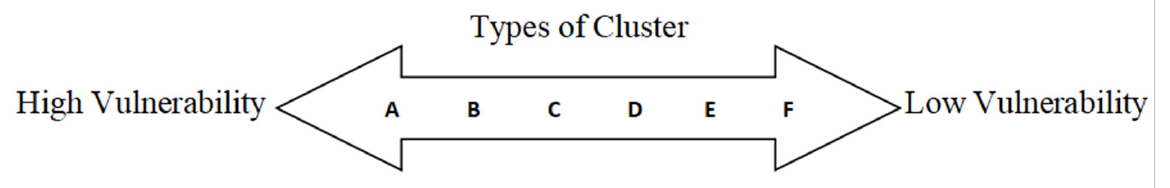
Figure 4. Comparison of the level of vulnerability between each of the clusters.